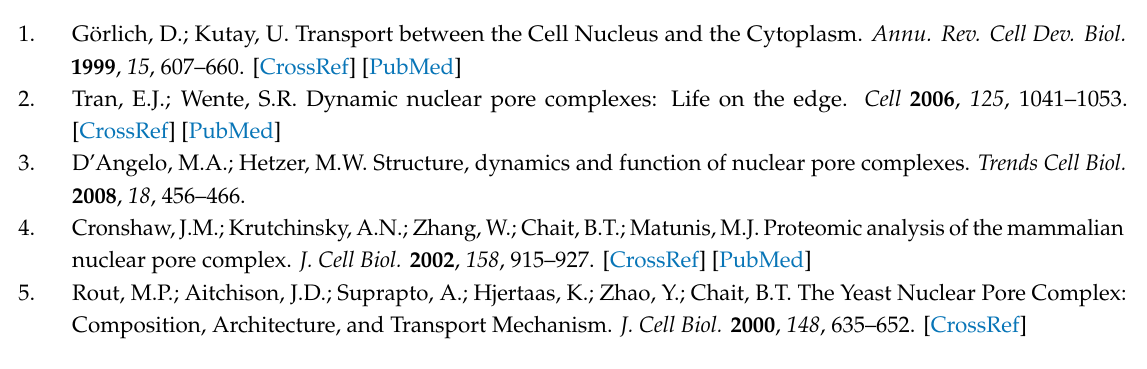
Figure S1: qRT-PCR experiments to confirm that UAS-RNAi stocks used in this study can deplete the relevant mRNAs e ffi ciently, Figure S2: Immunostaining of premeiotic spermatocytes to confirm that Nup54, another component of Nup62 complex is not localized on nuclear envelope in the Nup62-depleted spermatocytes, Figure S3: Intact cysts consisted of early spermatocytes generated from mitoses of spermatogonia and those of post-meiotic cells derived from spermatocytes depleted of